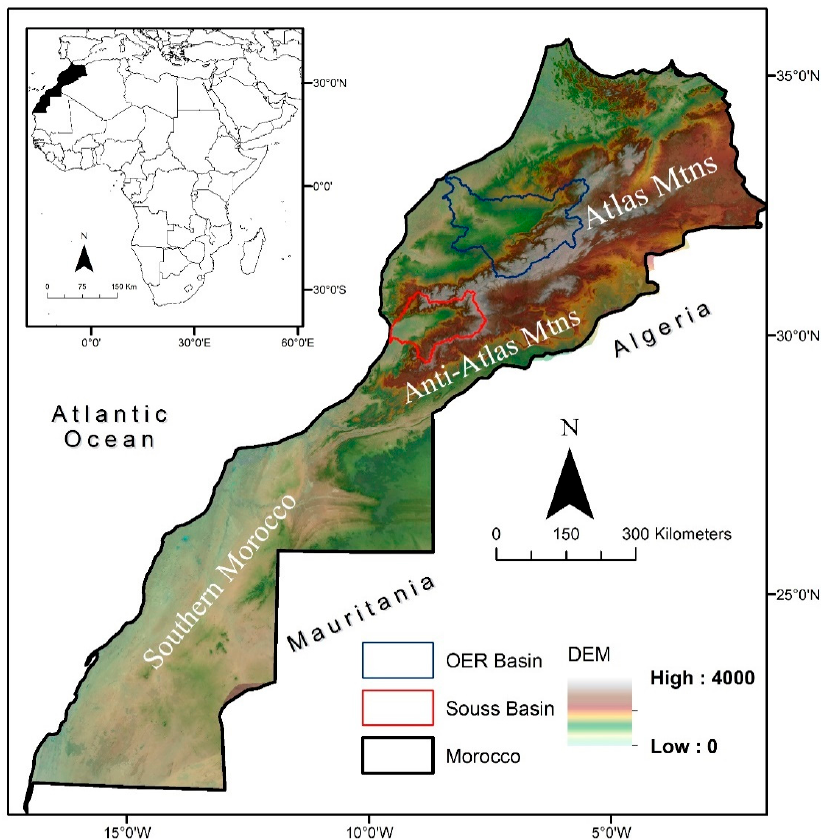
Figure 1. Digital Elevation Model of Morocco with the Souss (outlined in red) and Oum Er Rbia (outlined in blue) Basins highlighted.